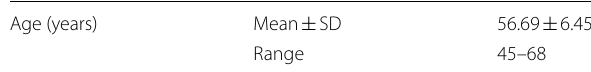
Table 1 Statistical data analysis for different ages enrolled in our